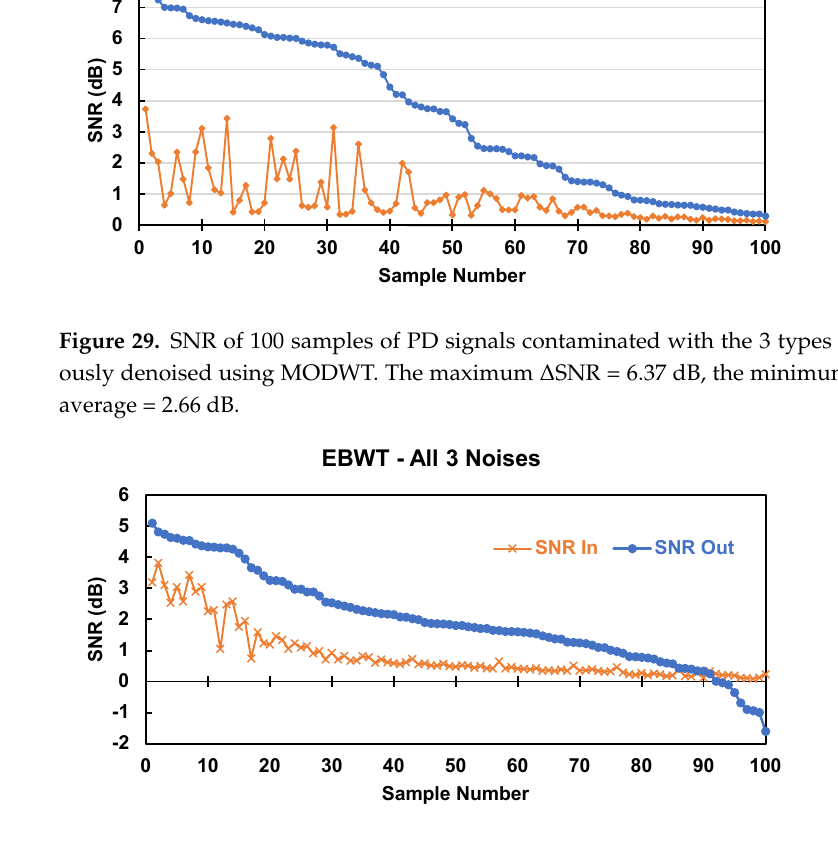
Figure 30. SNR of 100 samples of PD signals contaminated with the 3 types of noises simultane- ously denoised using EBWT. The maximum ∆ SNR = 3.25 dB, the minimum = − 1.83 dB, and the average = 1.11 dB.